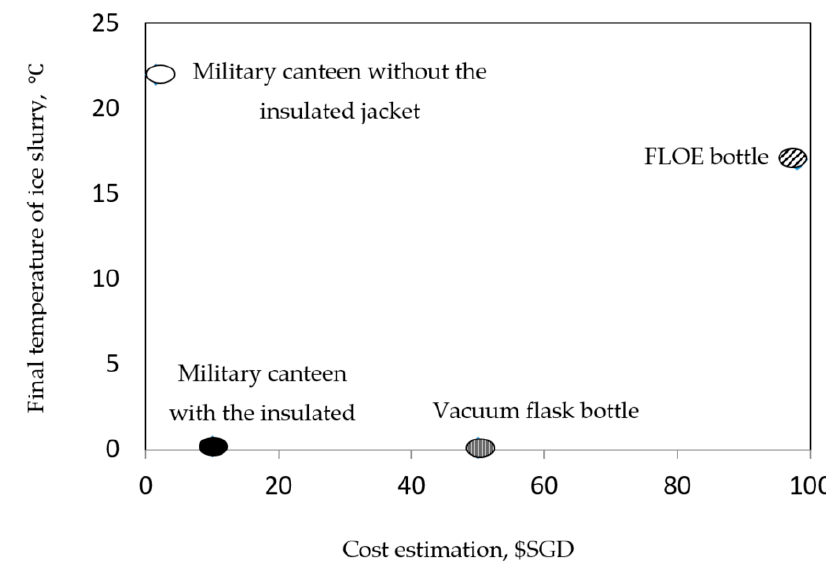
Figure 2. Comparison of the cost and heat insulation performance after 4 h of various bottles having the same 1-liter capacity.